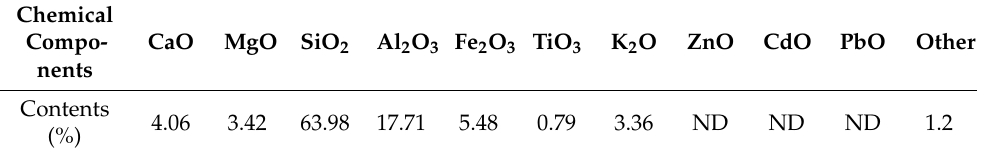
Table 2. Main chemical components of undisturbed